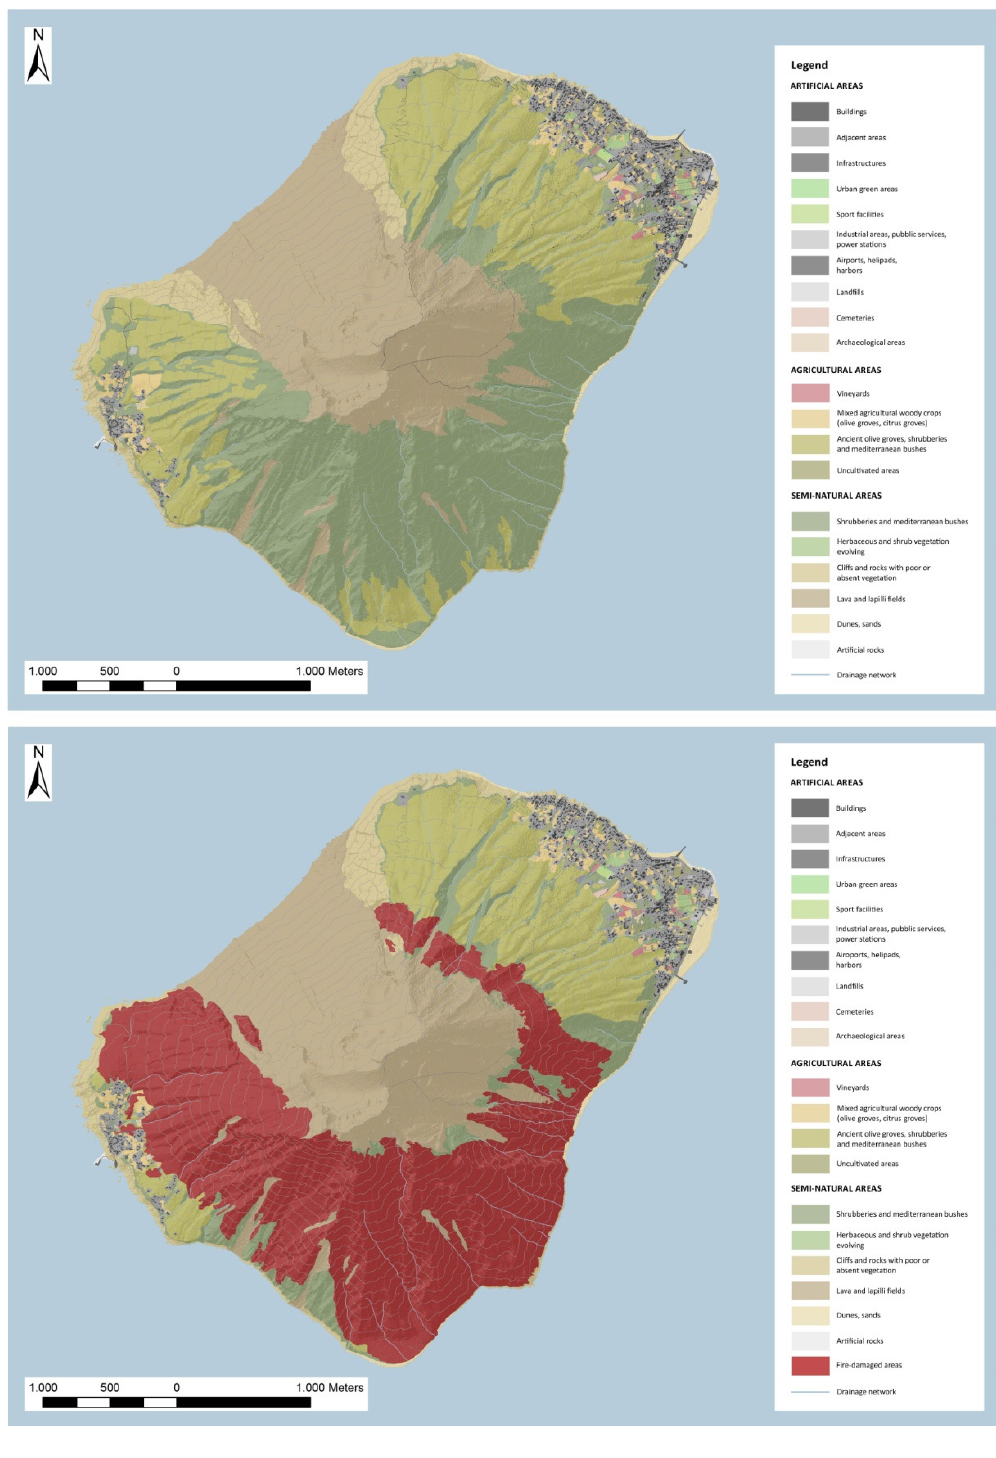
Figure 7. Land use map (LU) pre ‐ eruption (2018) and post ‐ eruption (2019).